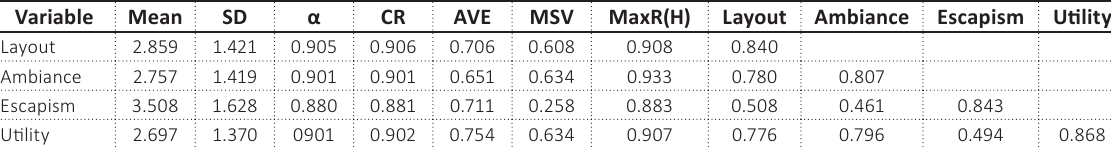
Table 3. Psychometric